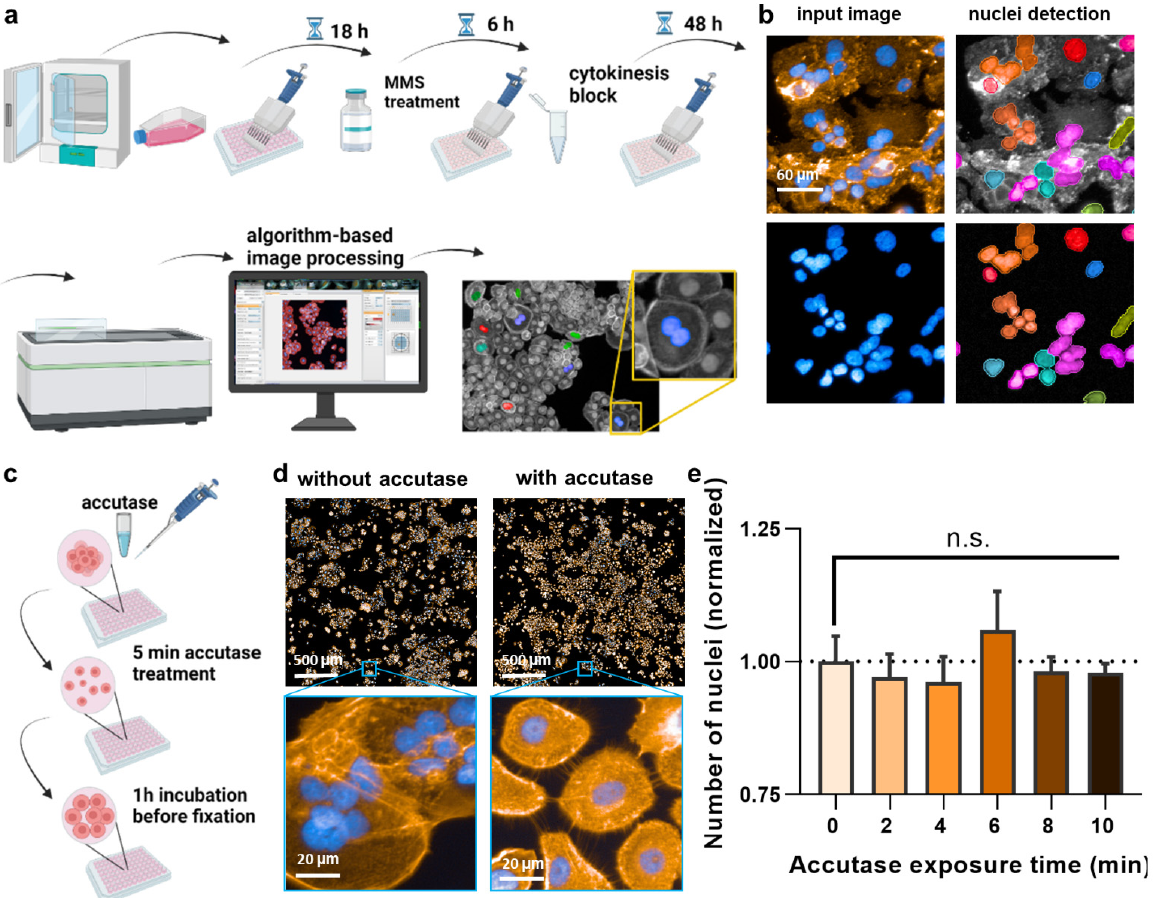
Figure 1. Study design and cell detachment. ( a ) Study design; ( b ) failure of original nuclear segmentation by software due to HaCaT keratinocytes’ aggregated cell growth; (c) scheme using a 5 min accutase treatment before fixation to lift and separate the cells without detachment; ( d ) representative image of the effect of accutase treatment on the separation of cells; ( e ) number of nuclei after 2–10 min of accutase exposure detachment, followed by addition of cell culture medium and 1 h incubation, and data normalization to cells not exposed to accutase (0), indicating that the initial accutase treatment does not lead to complete cellular detachment with subsequently less number of cells being identified by the software. Data are representative or mean + S.E.M. from at least three independent experiments. Statistical analysis was performed using one-way analysis of variances with Dunnett post hoc testing for multiple comparisons ( e ). n.s. = not significant.